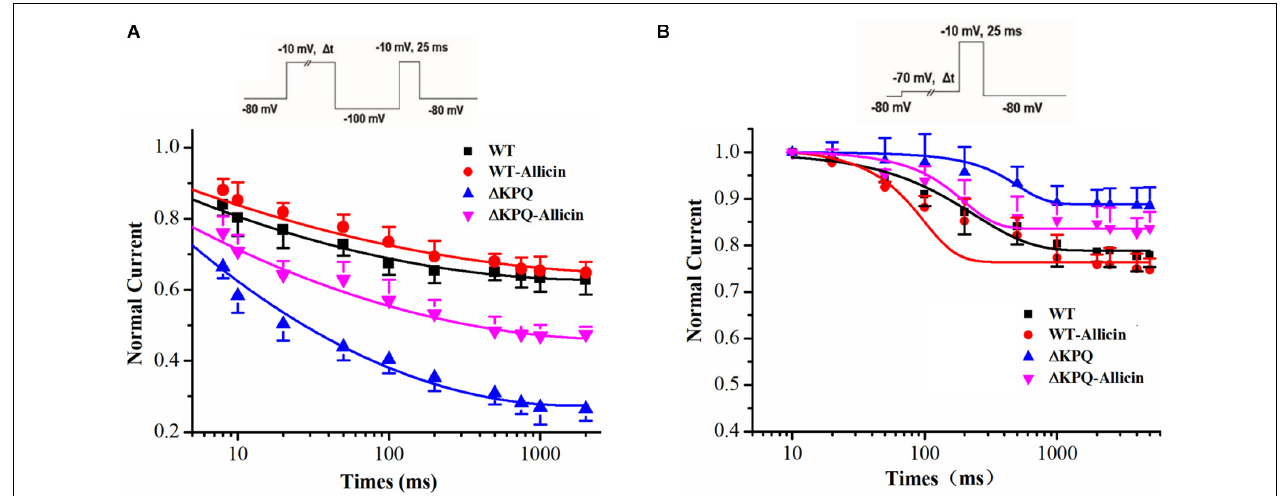
FIGURE 4 | Effect of Allicin on the intermediate-state inactivation (ISI) and closed-state inactivation (CSI) of the (cid:49) KPQ-SCN5A mutation current. (A) Time constant of the ISI of the (cid:49) KPQ-SCN5A mutation current were changed by 30 µ M Allicin. (B) Representative time constants of the CSI were not affected by 30 µ M Allicin.